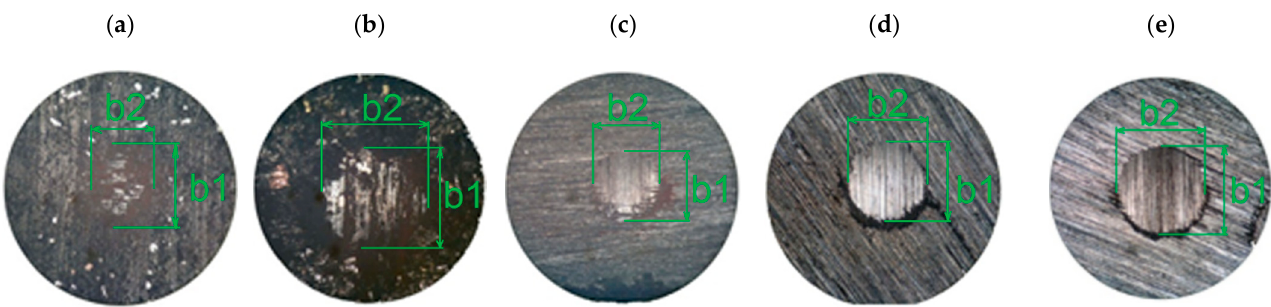
Figure 7. Sample photos of craters created during research: ( a ) first group of samples, q = 40%; ( b ) second group of samples, q = 15%; ( c ) second group of samples, q = 70%; ( d ) third group of samples, q = 80%; ( e ) third group of samples, q = 100%.